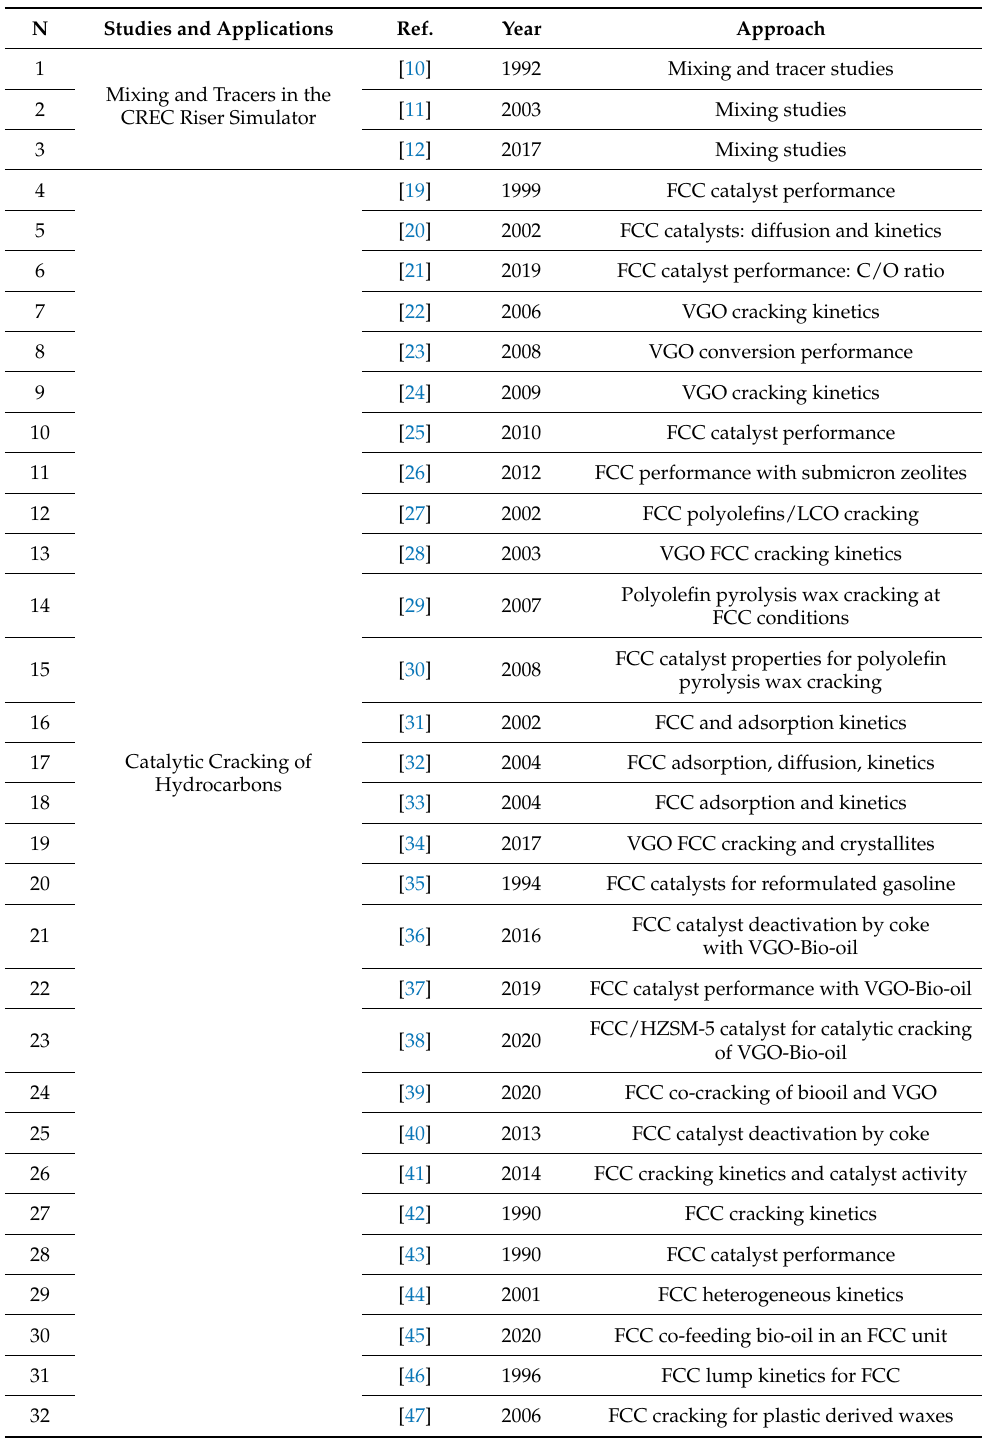
Table 5. Applications of the CREC Riser